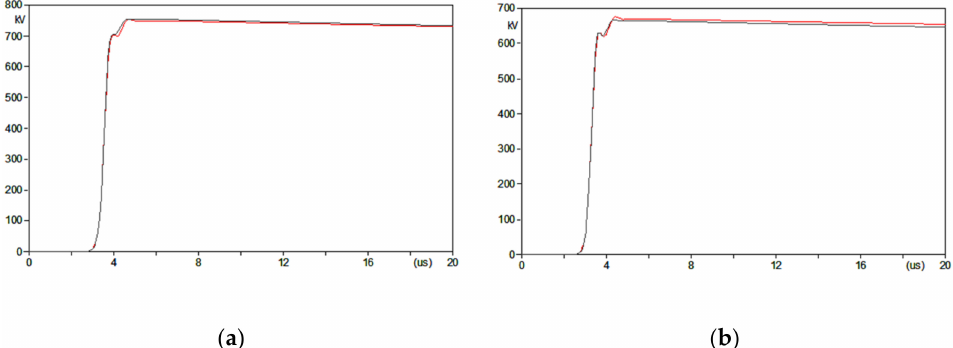
Figure 7. GPR plots against time for MT4 grounding arrangement directly injected by a lightning current. Red line: full circuit model; black line: pi-circuit model. ( a ) ρ g = 600 Ω m, I P = 58 kA,